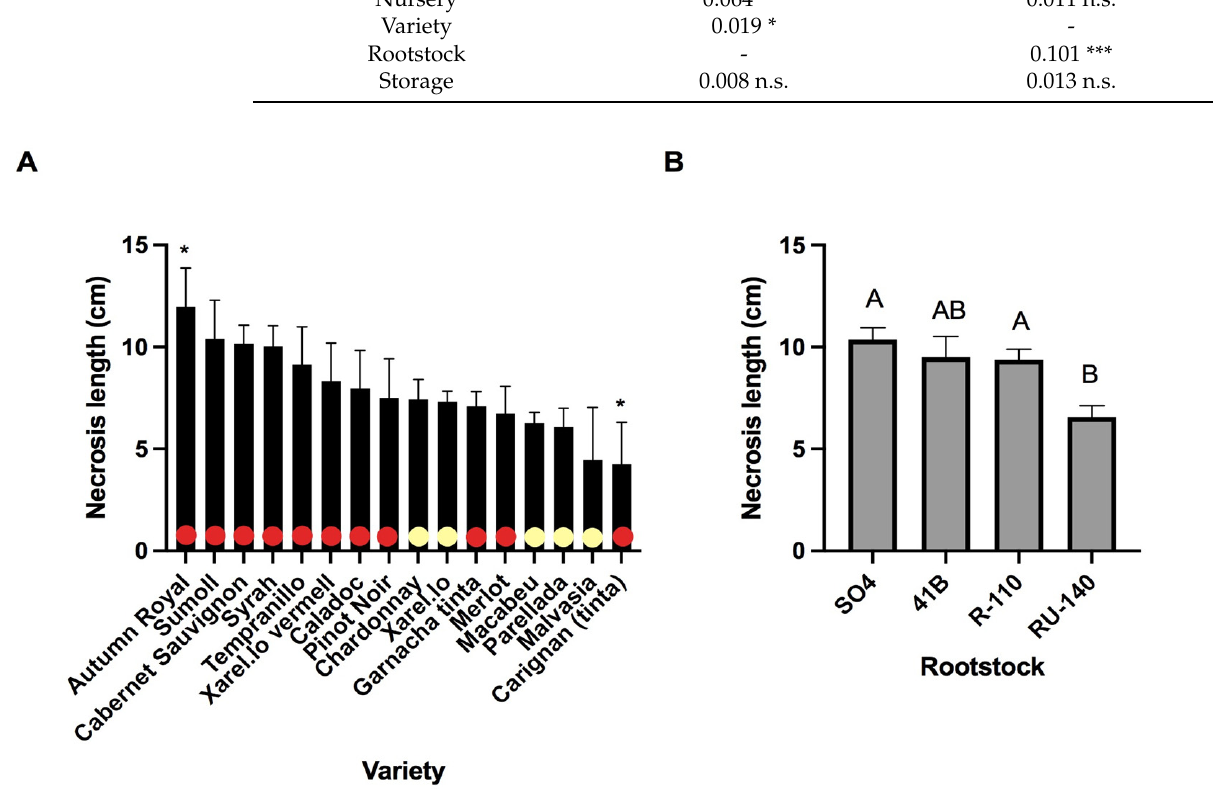
Figure 1. ( A ) Mean necrosis length (cm) in graft unions for each variety. Variety color is indicated with red and yellow dots for red and white varieties, respectively. Statistically significant coefficients are marked with asterisks: p < 0.05 (*). ( B ) Mean necrosis length in root collars from each rootstock. Post hoc comparisons using Student’s t -test were made and levels not connected by the same letter are significantly different.